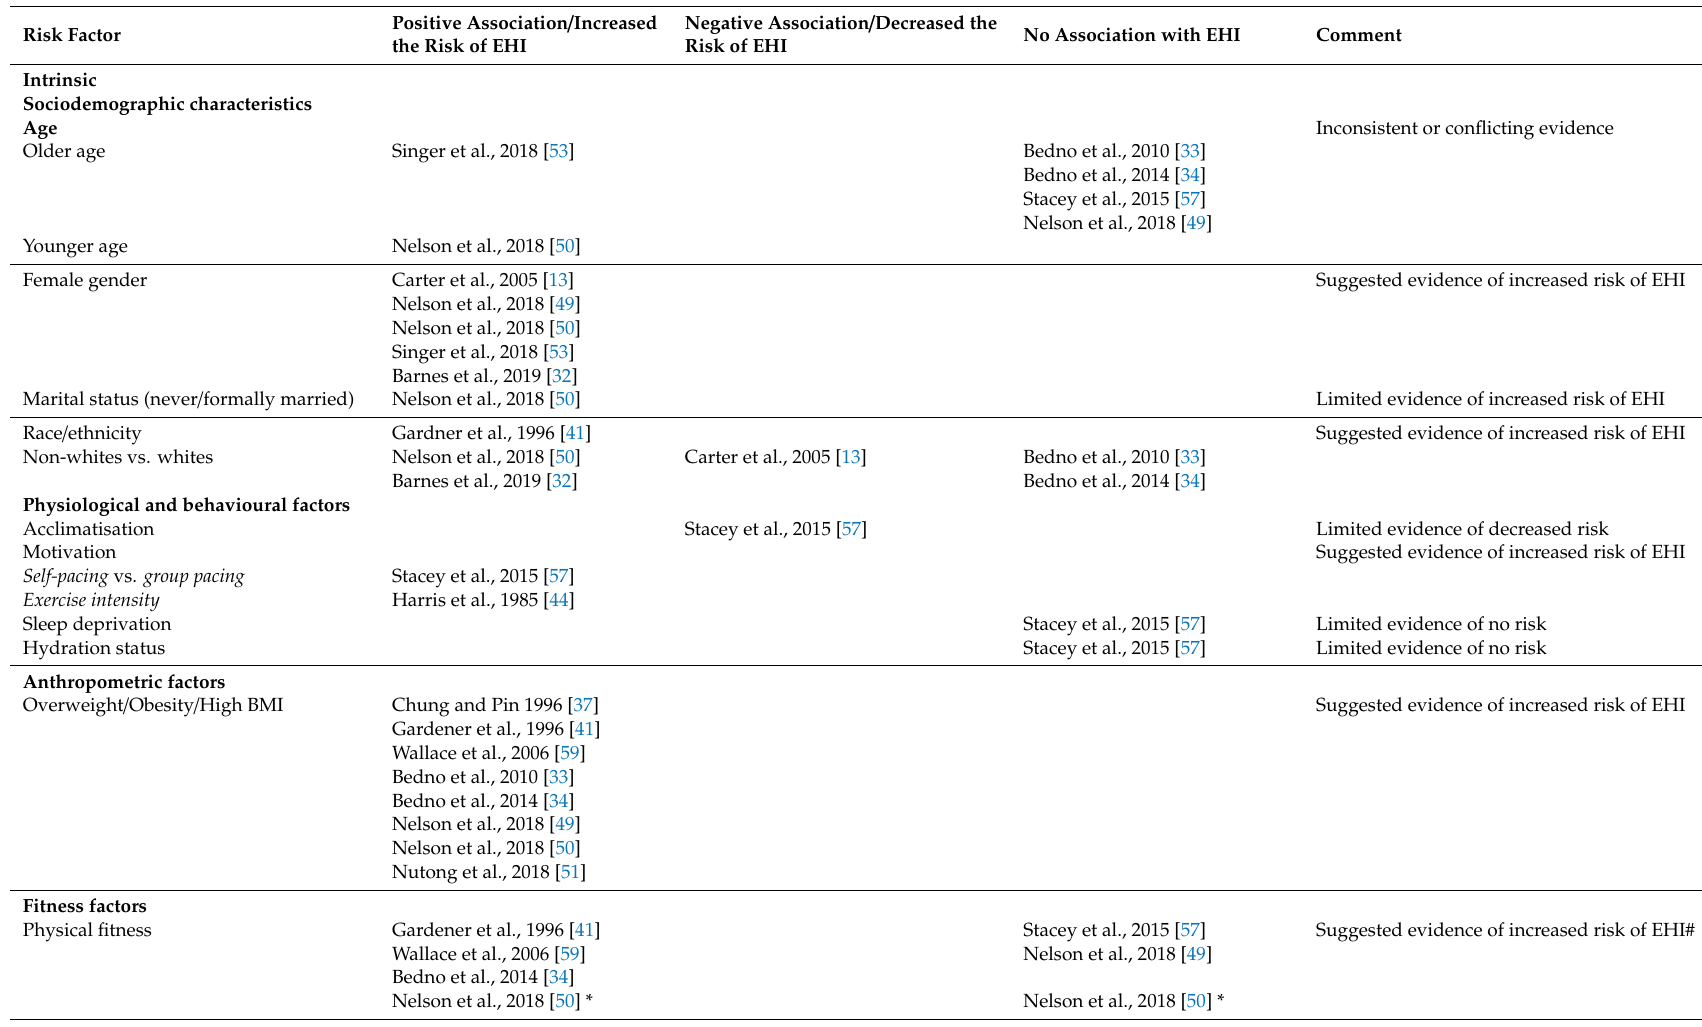
Table 3. Risk factors associated with exertional heat